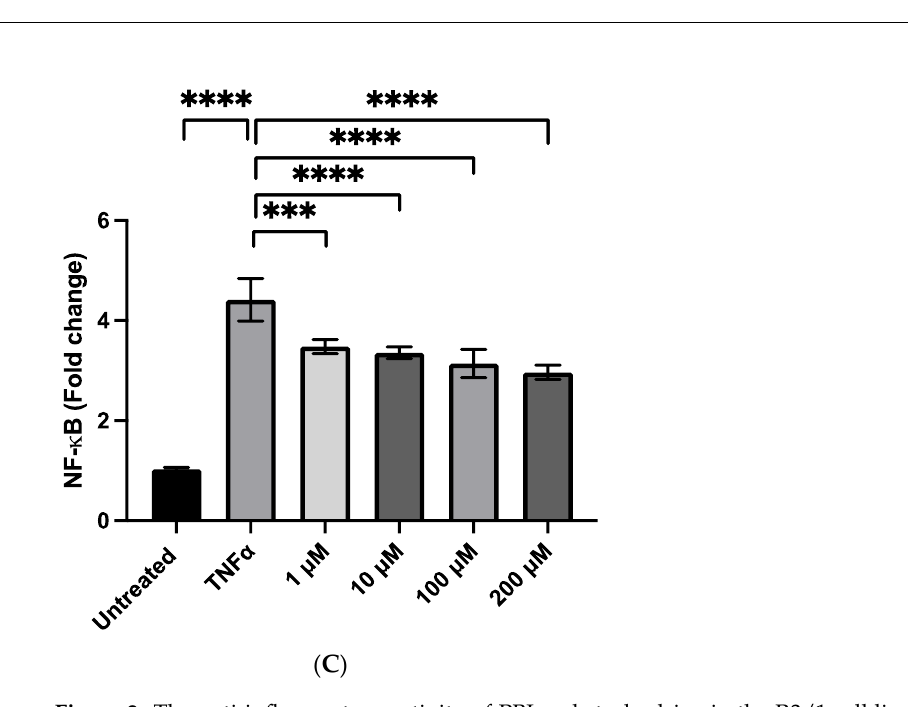
Figure 2. The anti-inflammatory activity of PBJ and stachydrine in the R3/1 cell line with a gene reporter for NF-kb. The effects of PBJ are shown before ( A ) and after ( B ) extraction in a hydro-alcoholic mixture and under sonication to release the small molecules from the polymeric matrix. The dose-dependent anti-inflammatory effect of stachydrine is shown in panel ( C ). ***p < 0.001; ****p < 0.0001.